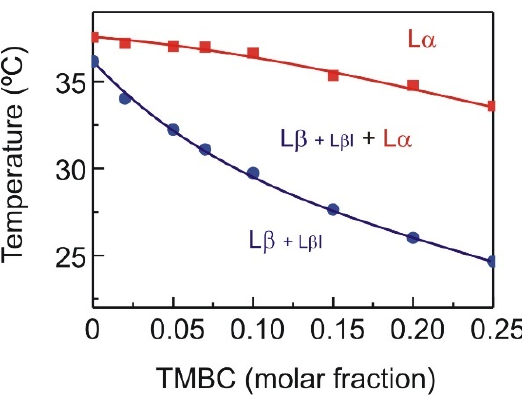
Figure 4. Partial phase diagrams for DMPS in DMPS/TMBC mixtures. Circles and squares were obtained from the onset and completion temperatures of the main gel to liquid crystalline phase transition, respectively. Circles, solidus line; squares, fluidus line. The phase designations are as follows: L β , gel phase; L β I, interdigitated gel phase; L α , liquid crystalline phase (fluid phase).